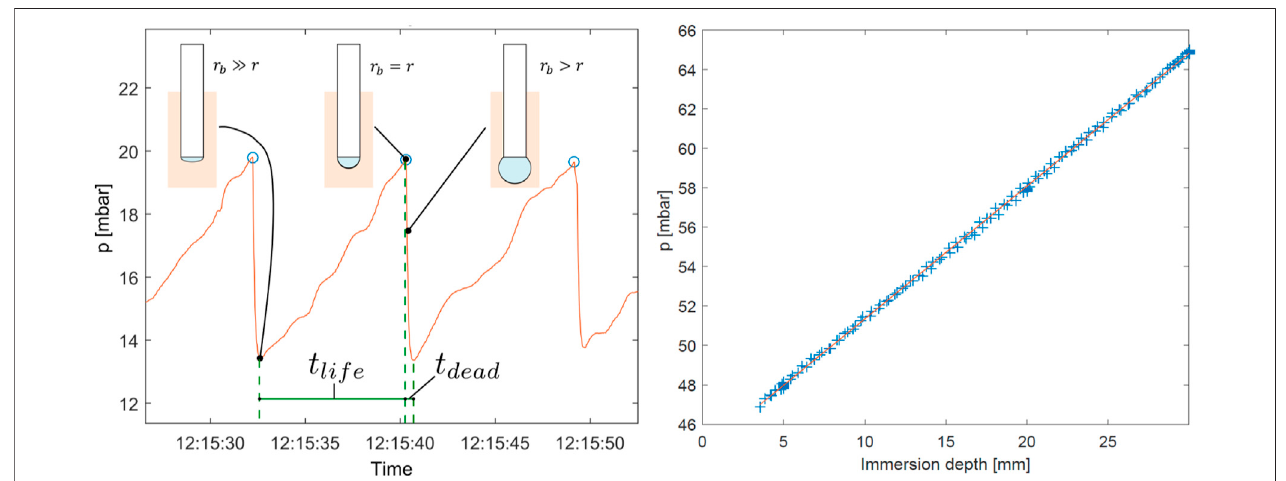
FIGURE5| PrincipleofVITI-MBPmeasurementsatgiventemperature T .Left:pressure p peakdetectionatgivenimmersion depth h .Right:linearcorrelation p ( h ) .